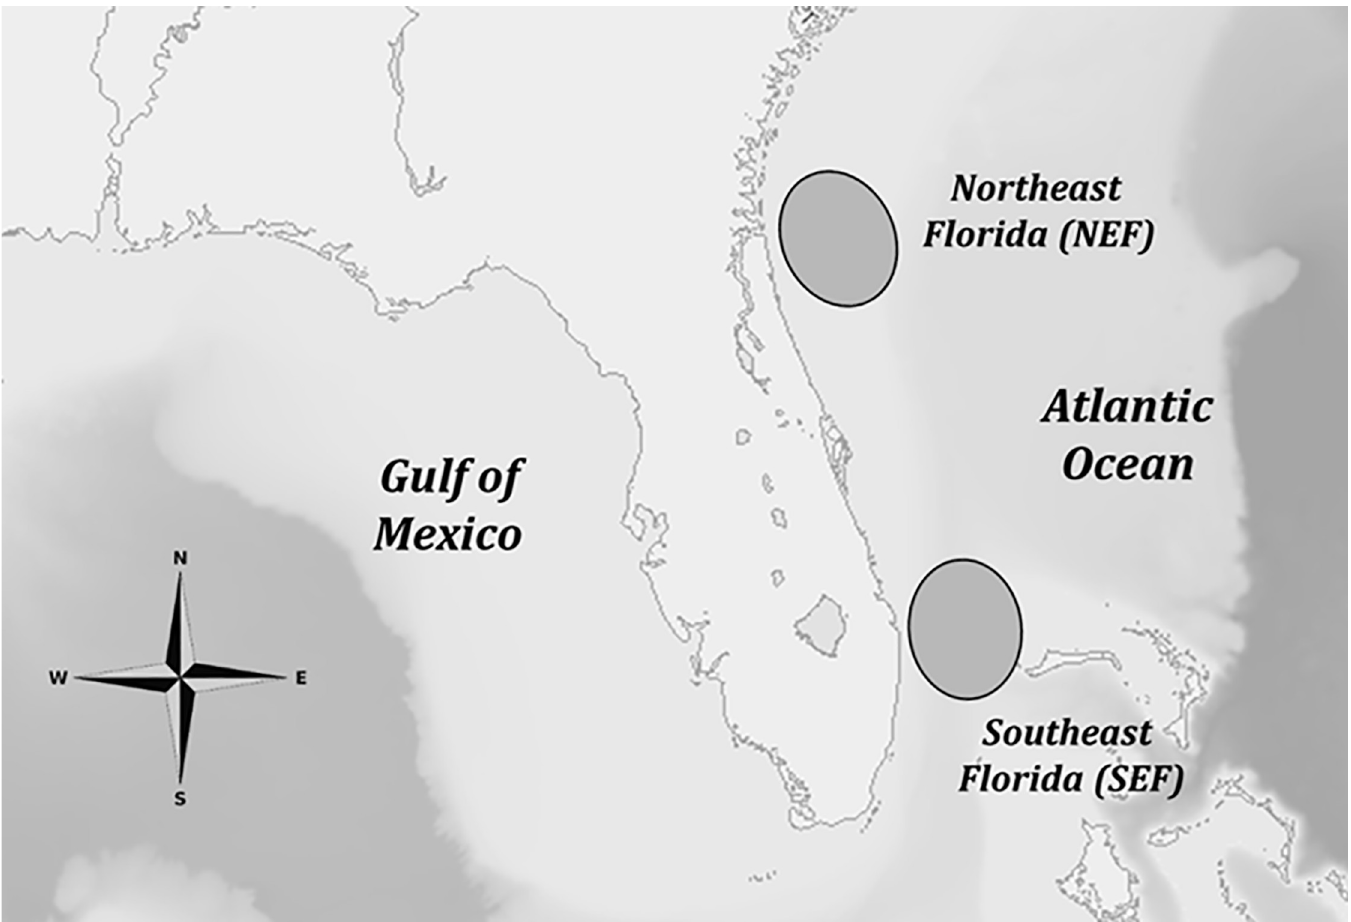
Fig 1. Map of study locations. Location of lionfish collection sites from northeast (NEF) and southeast (SEF) Atlantic coasts of Florida. The final figure was modified from a base map created using the USGS National Map Viewer (public domain): http://viewer.nationalmap.gov/viewer/.